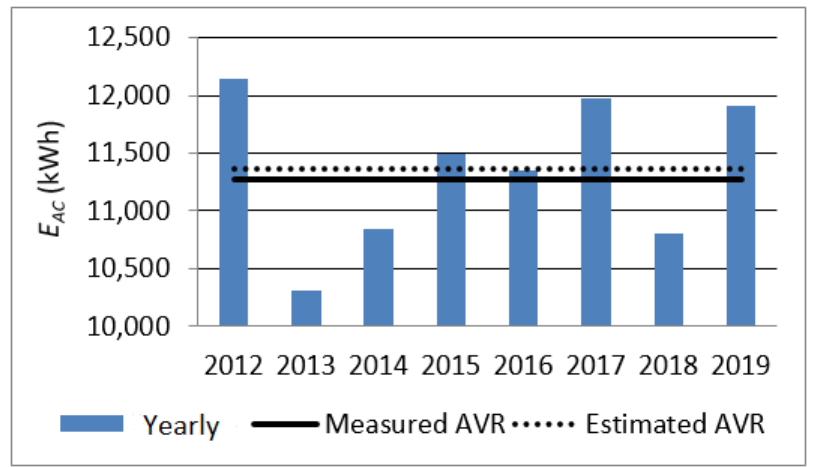
Figure 3. The FTS PV power plant generated electrical energy, measured and estimated average value.